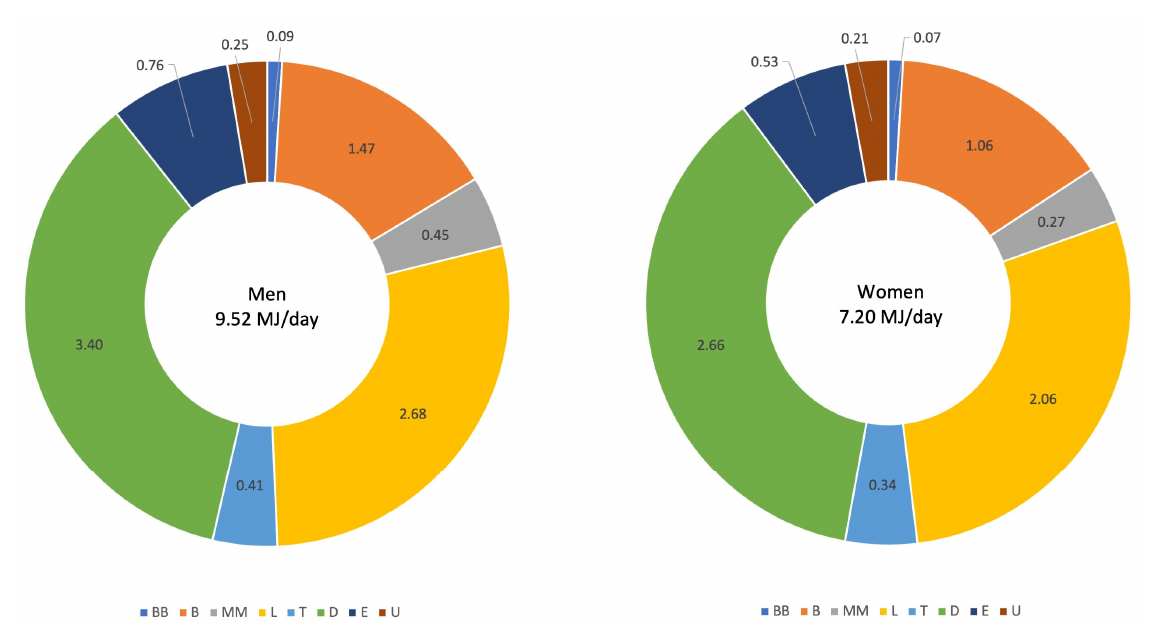
Figure 1. Estimated marginal means (95%CI) of triglyceride and glucose concentrations stratified by sex and adjusted for age and waist circumference (continuous). The axes have been made com- parable with the axes in subsequent figures to facilitate comparisons.